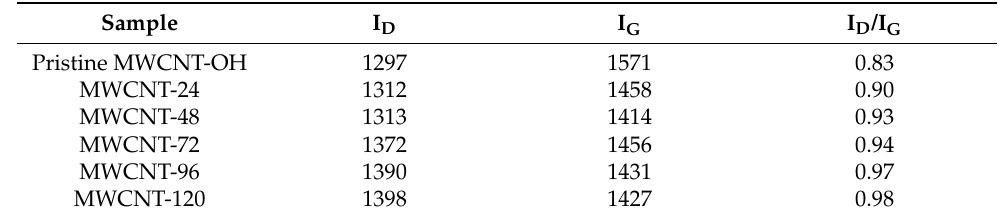
Table 1. Intensity ratio of the I D /I G band of pristine MWCNT-OH and P3HT/MWCNT-OH